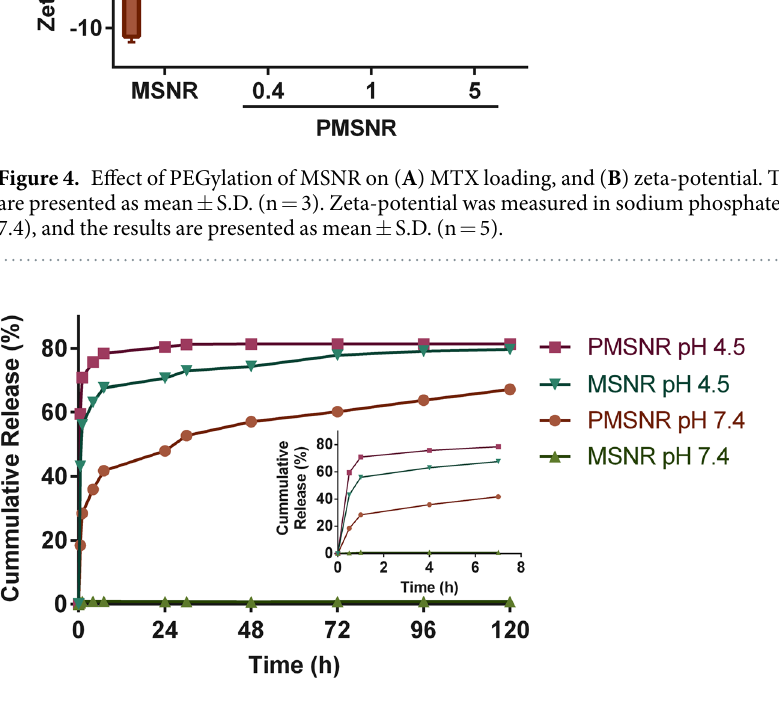
Figure 5. Effect of PEGylation of MSNR on drug release. The released amount of MTX was determined from supernatant absorption at 658 nm. (Inset: detailed release within the first 7